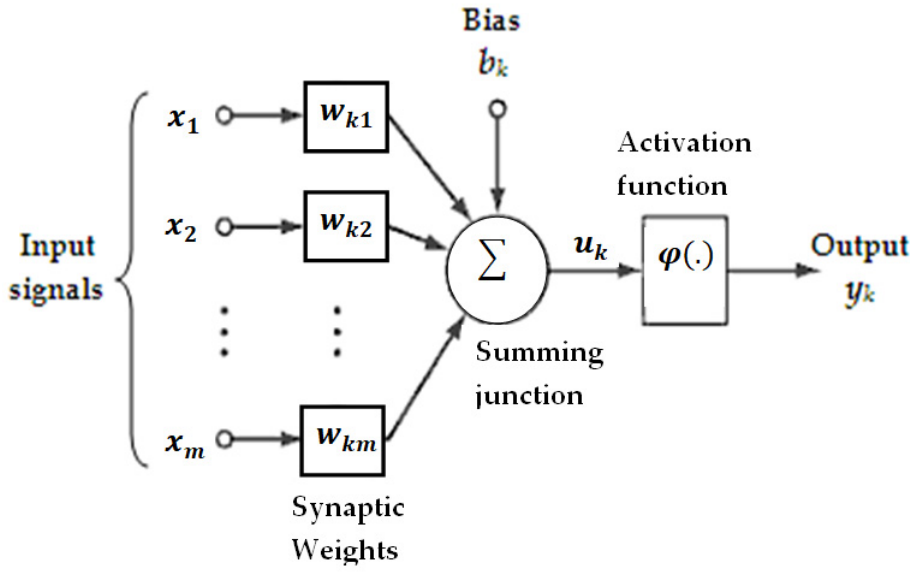
Figure 3. An artificial neuron model structure [78].